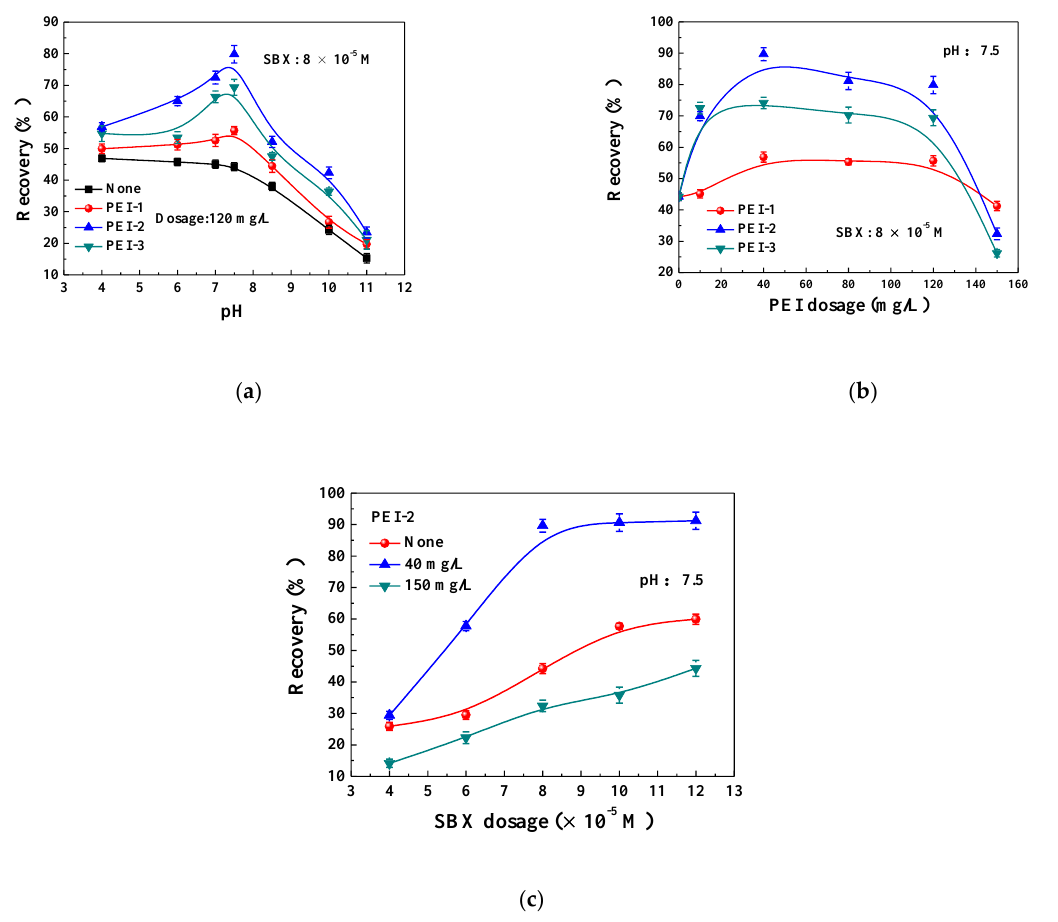
Figure 5. Effects of ( a ) pH (PEI, 120 mg/L; SBX, 8 × 10 − 5 M), ( b ) PEI dosage (pH, 7.5; SBX, 8 × 10 − 5 M) and ( c ) SBX dosage (pH, 7.5) on the recovery of arsenopyrite.